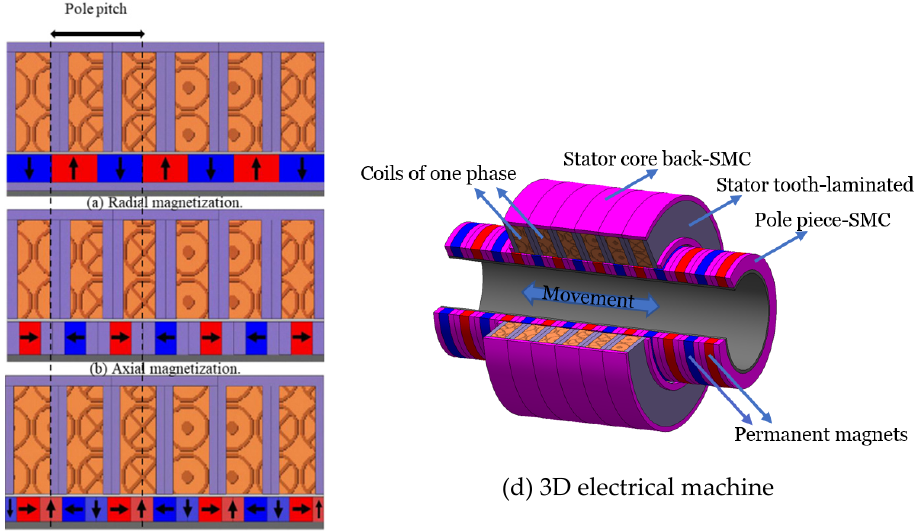
Figure 4. Electrical machine topologies investigated.